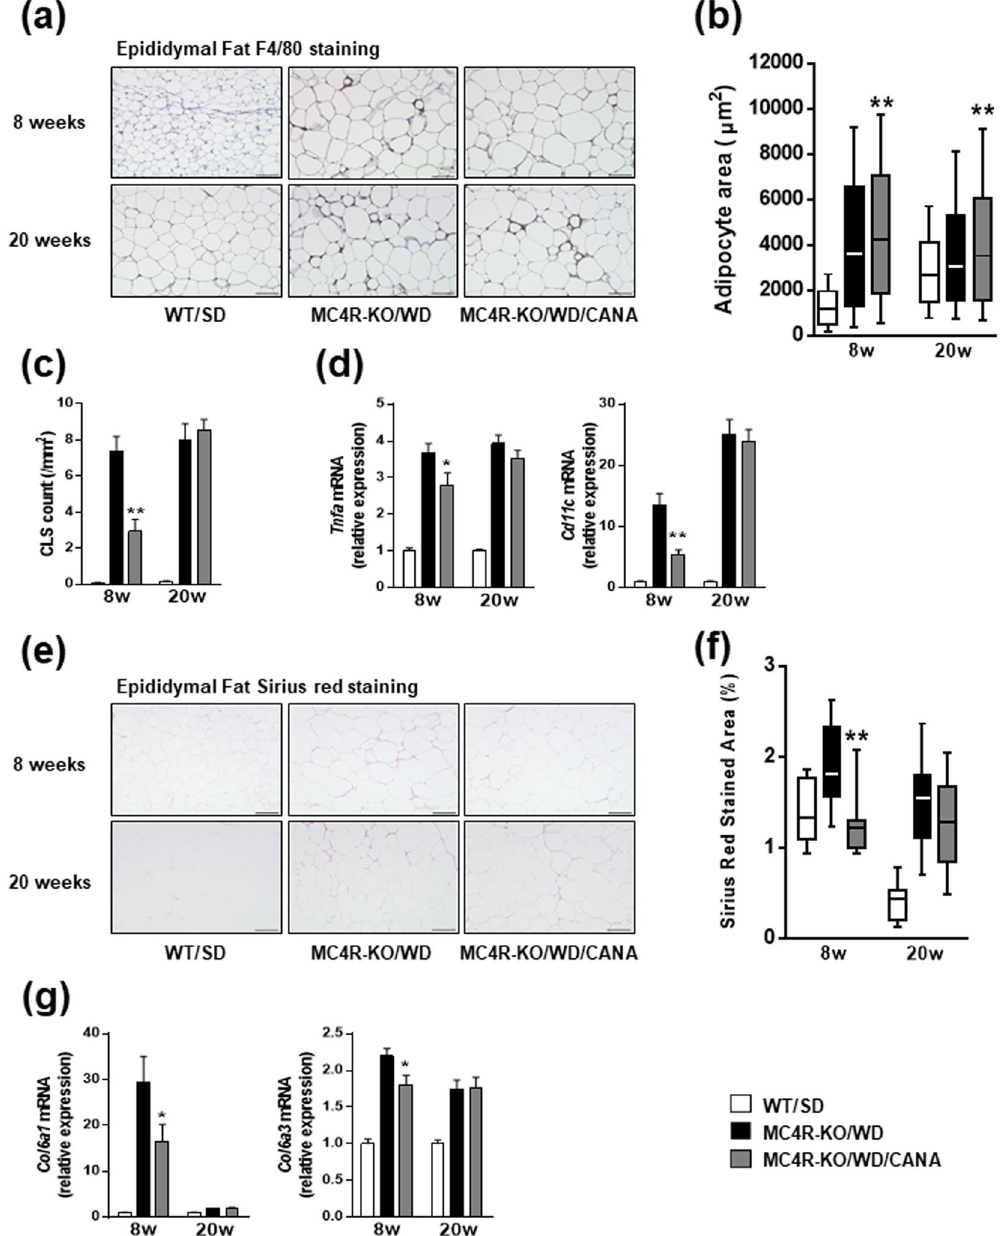
Figure 3. CANA reduces inflammation and fibrosis in adipose tissue of WD-fed MC4R-KO mice. ( a ) F4/80 immunohistochemical analysis of epididymal fat. ( b ) Adipocyte area in epididymal fat. ( c ) Quantification of the number of crown-like structure (CLS) in epididymal fat. ( d ) Expression levels of inflammation-related genes in epididymal fat. ( e ) Sirius red staining of epididymal fat and ( f ) quantification. ( g ) Expression levels of collagen genes in epididymal fat. Original magnification, × 200. Scale bars, 100 μ m. * p < 0.05, ** p < 0.01 vs MC4R-KO/ WD. Statistical analyses were performed using Kruskal‐Wallis test ( b and f ) or one-way ANOVA ( c , d and g ) followed by Dunn or Bonferroni post hoc test, respectively; MC4R-KO/WD and MC4R-KO/WD/CANA was pre-selected as a subset of means or medians to compare. n =